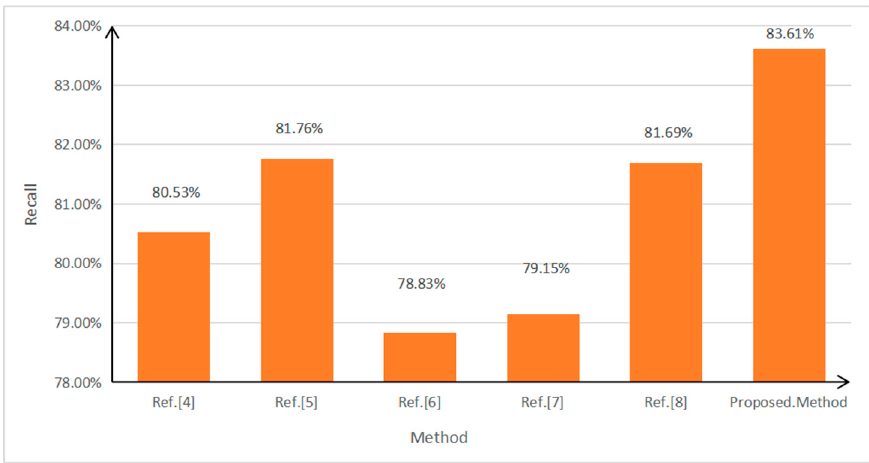
Figure 12. Recall values of various front-vehicle detection methods.